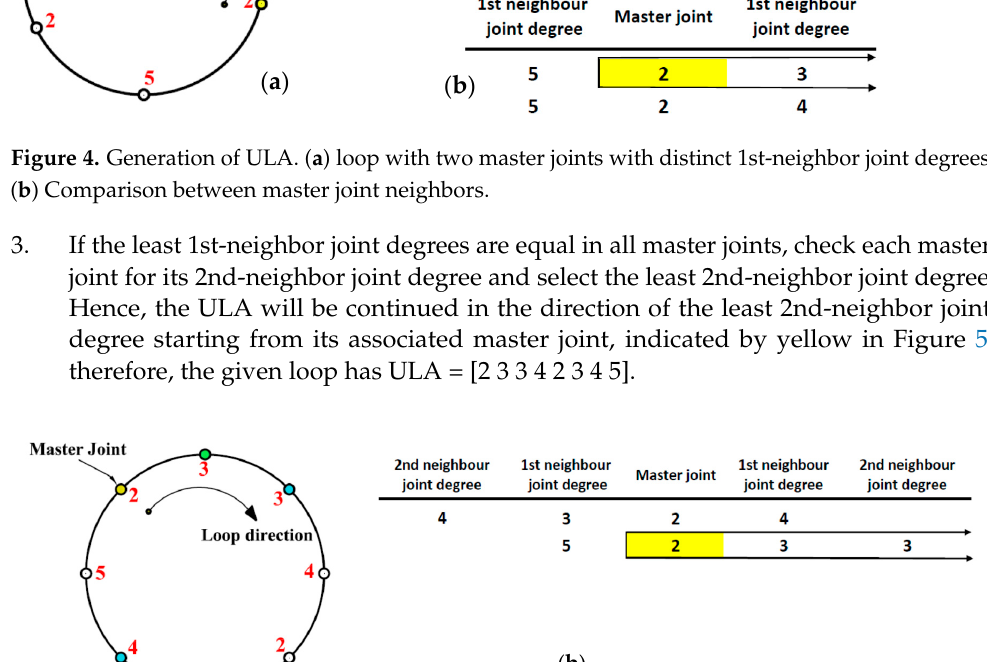
Figure 3. Examples for loops that have a single master joint. ( a ) non equal 1st neighbor joint degrees. ( b ) equal 1st neighbor joint degrees. ( c ) equal 1st and 2nd neighbor joint degrees.